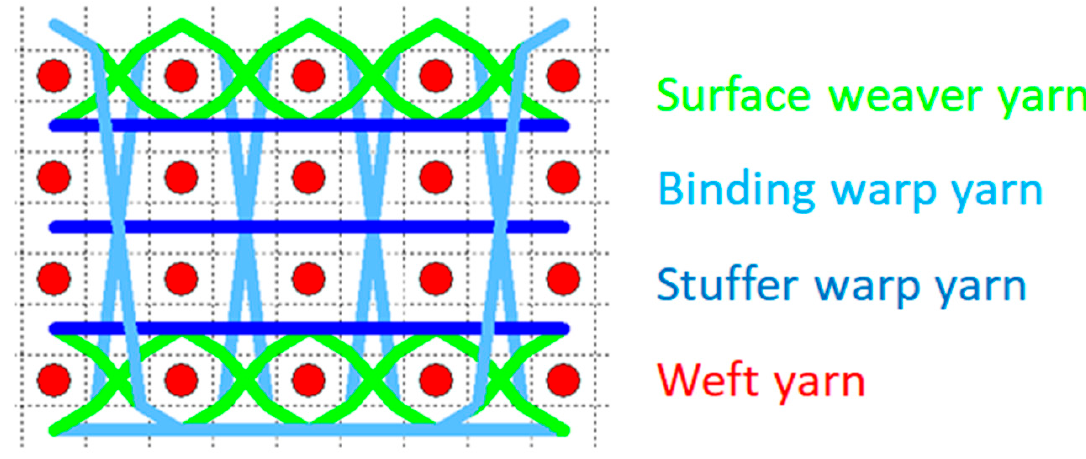
Figure 1. Schematic representation of the three-dimensional (3D) warp interlock fabric.